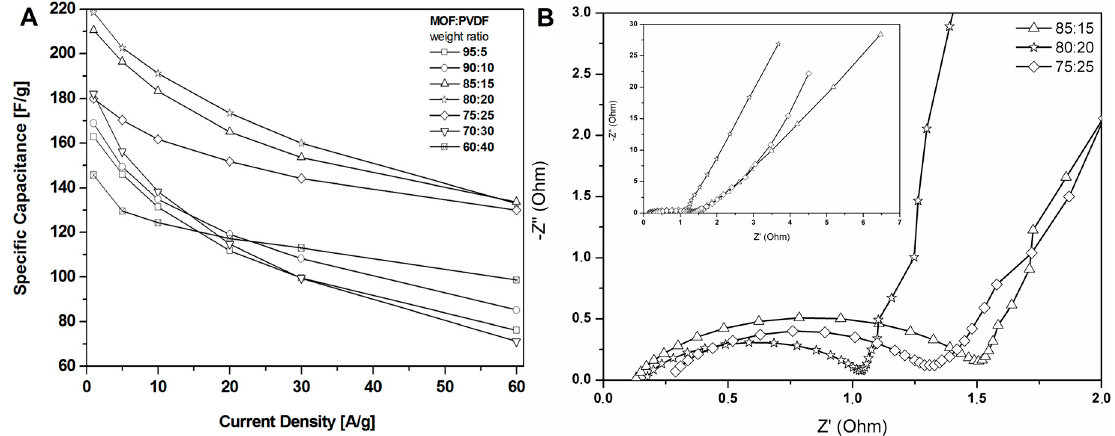
Figure 7. The specific capacitance curves ( A ) and Nyquist plots ( B ) of the electrodes prepared by evaporation with different ratios MOF:PVDF.